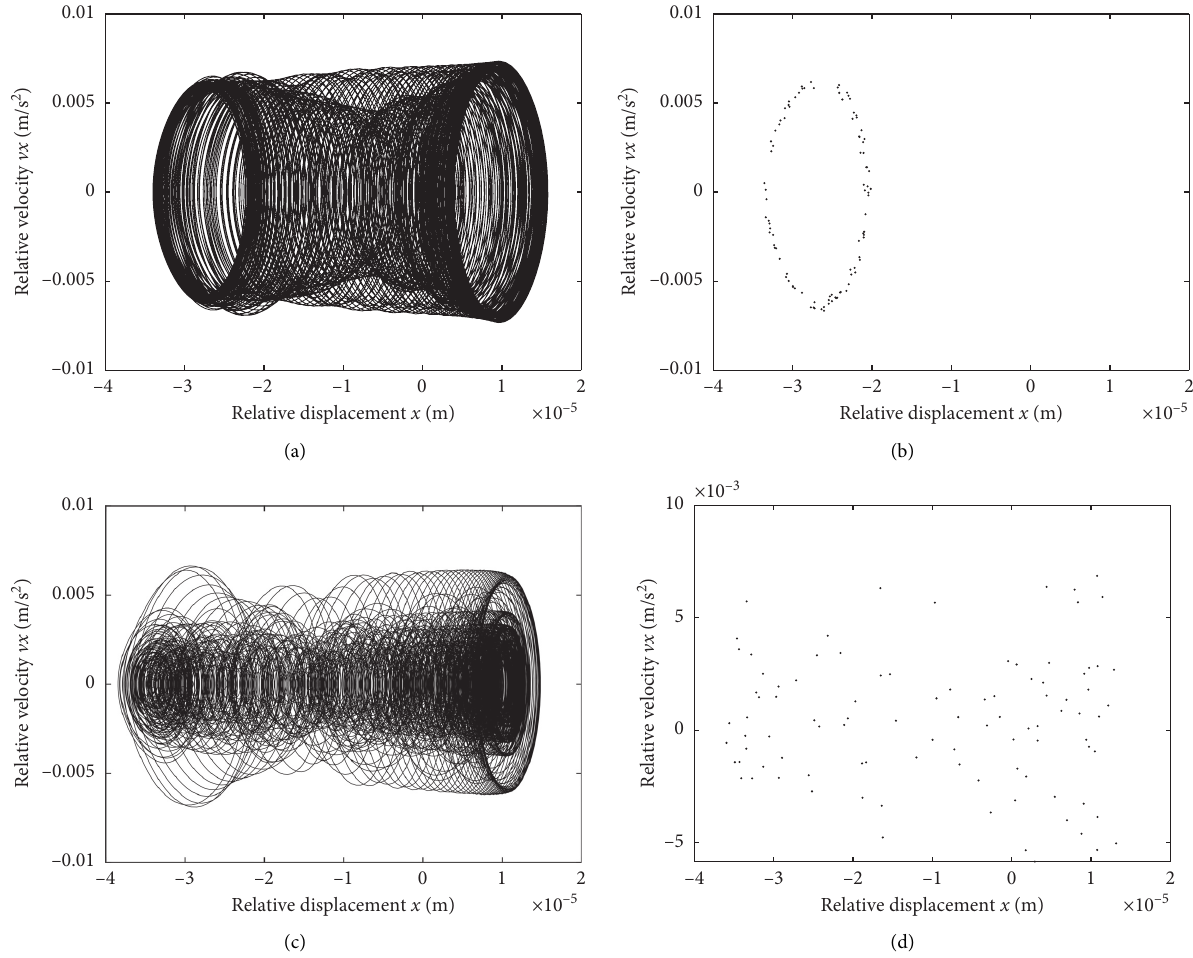
Figure 27: Phase trajectories and Poincare maps of X -direction clearances with different clearance values at clearance A. (a) Phase trace � − 2 π ( rad/s ) , ω � 2 π ( rad/s ) . (b) Poincare map at clearance A when the driving diagram at clearance A when the driving velocities are ω 2 7 � − 2 π ( rad/s ) , ω � 2 π ( rad/s ) . (c) Phase trace diagram at clearance A when the driving velocities velocities are ω 2 7